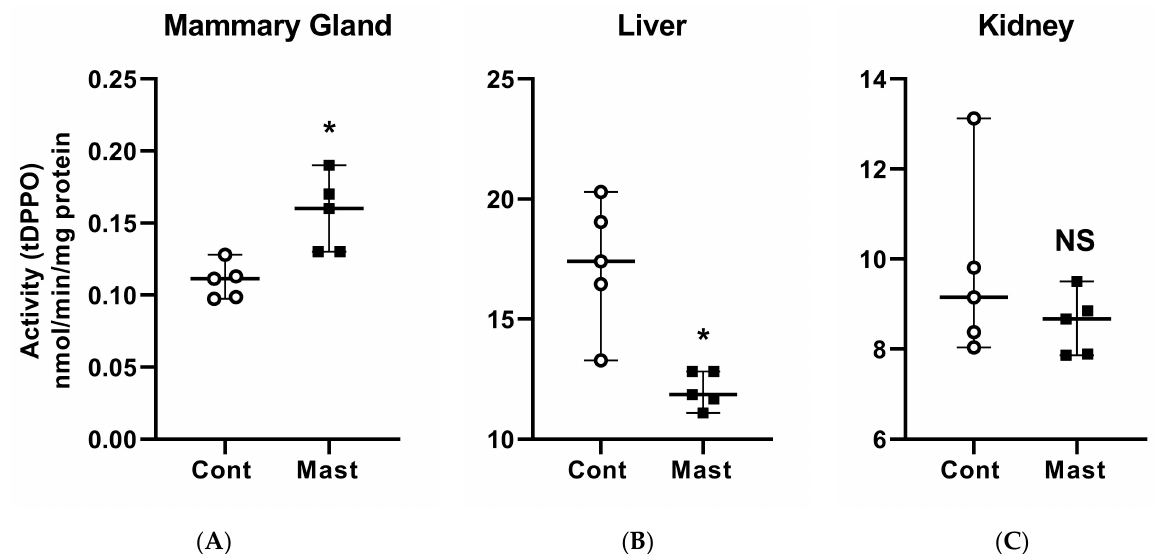
Figure 1. Soluble epoxide hydrolase enzymatic activity based on the metabolism of [ 3 H]- trans -diphenyl-propene oxide (t-DPPO) (median and range) in the mammary gland ( A ), liver ( B ), and kidney ( C ) tissues from healthy control (Cont) dairy cows (open circles, n = 5) and those with systemic coliform mastitis (Mast) (filled black squares, n = 5). Data were analyzed with Wilcoxon rank-sum tests ( α = 0.05). * p < 0.05, NS—not significant.